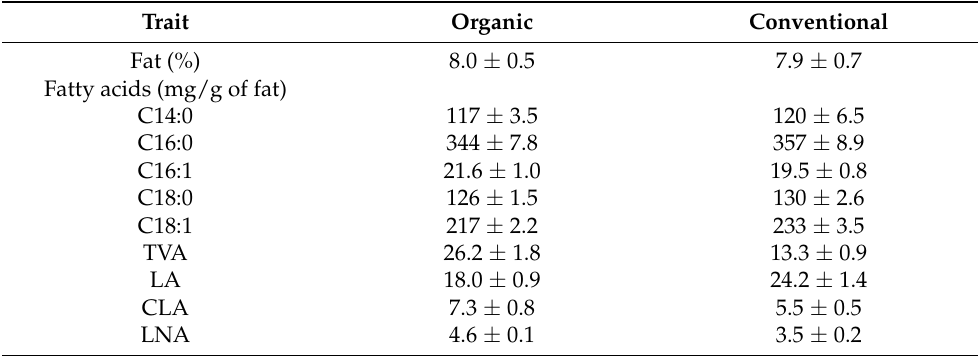
Table 4. Fat percentage and fatty acid composition of buffalo milk relative to organic and conven- tional management. Trait Organic Conventional Fat (%) 8.0 ± 0.5 7.9 ± 0.7 Fatty acids (mg/g of fat)